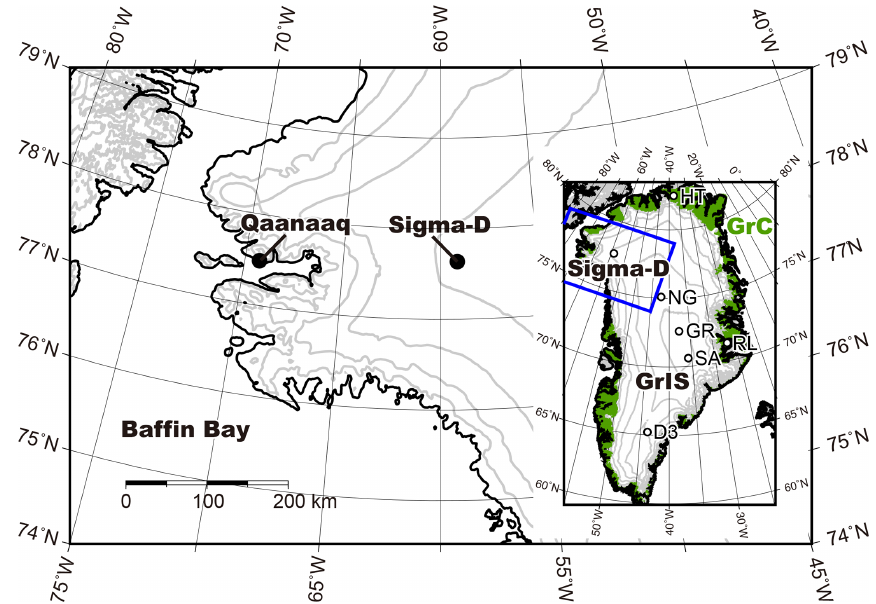
Figure 1. Location map of the SIGMA-D site (77.636 ◦ N, 59.120 ◦ W, 2100ma.s.l.). Contour lines are drawn at a 500m interval. The blue frame in the inset map of Greenland (GrIS) denotes the domain of the main map. The green shaded region in the inset map denotes the ice-free coastal terrain (GrC), and HT, NG, GR, RL, SA, and D3 denote Hans Tausen, NGRIP, GRIP, Renland, Site-A, and Dye-3 ice core sites for the back-trajectory comparison,